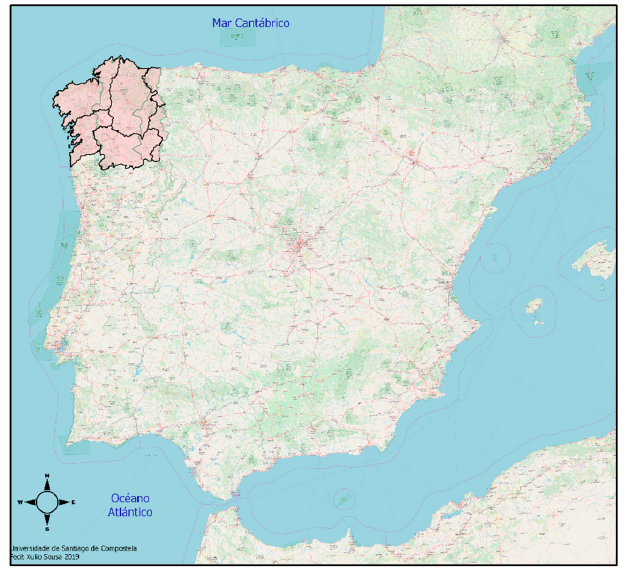
Figure 1. Galician linguistic domain in the Iberian Peninsula.